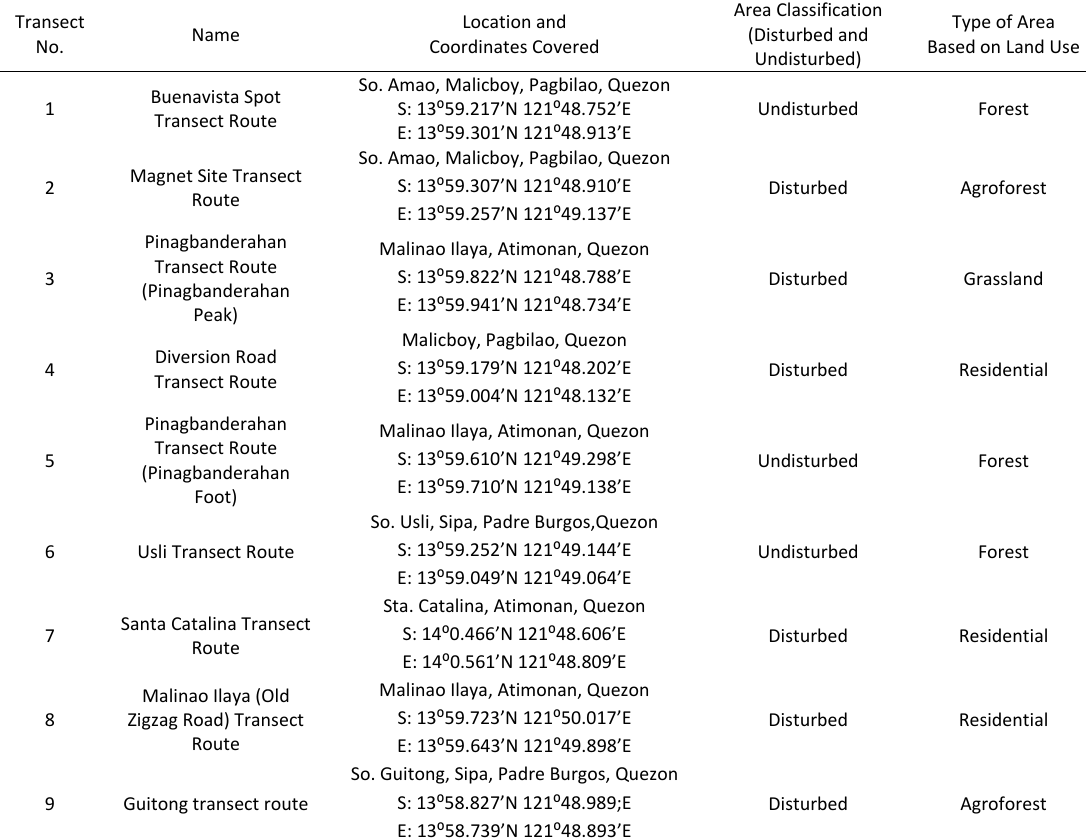
Table 1: Established transects